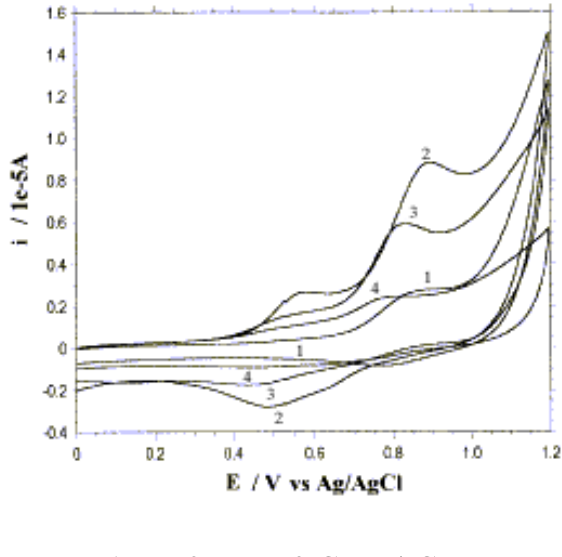
1- L, 2-MnL, 3-CuL,